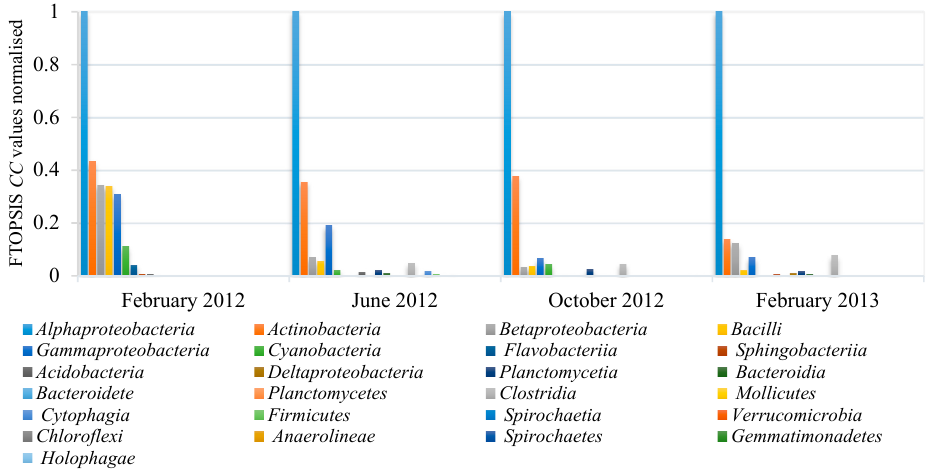
Figure 3. FTOPSIS results with bars heights normalised to the max 𝐶𝐶 value (varying between 0 and 1).